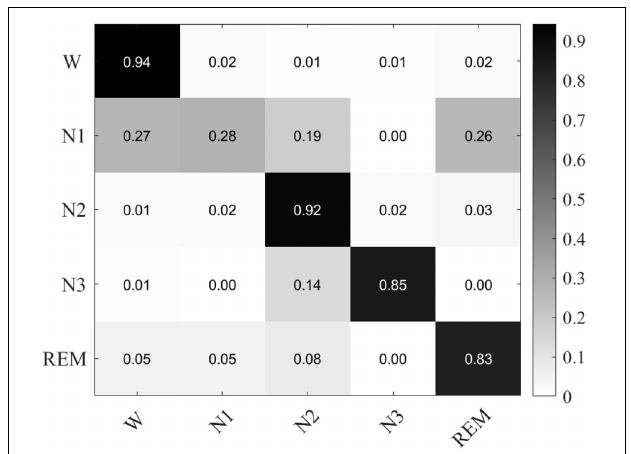
FIGURE 5 | The confusion matrix of classification experiments result based on single channel multimodal data.